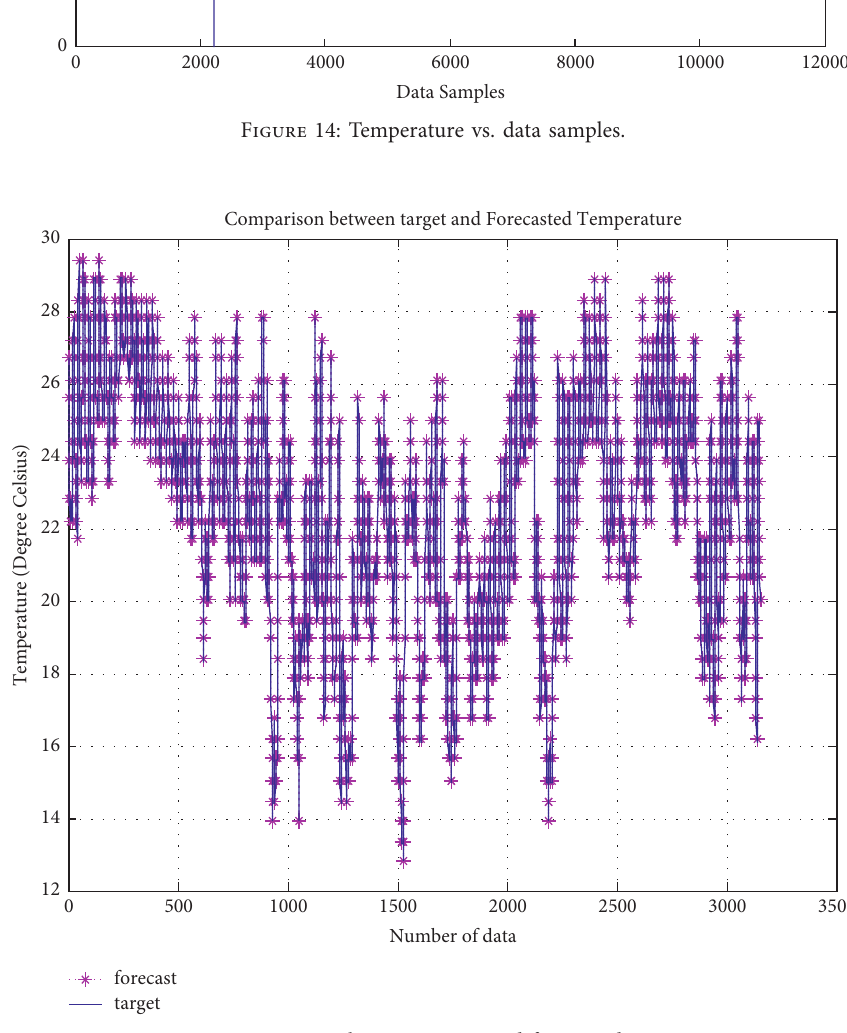
Figure 15: Comparison between target and forecasted